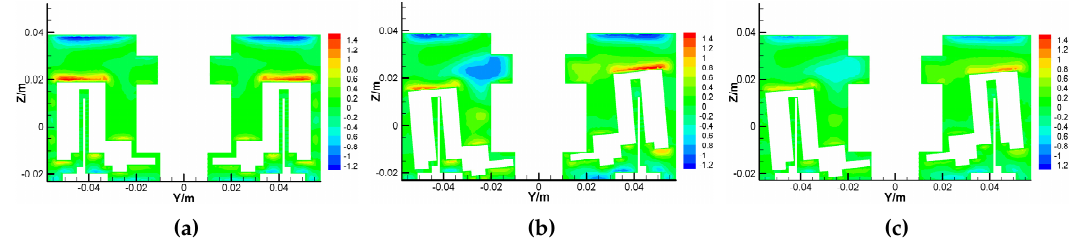
Figure 12. Radial velocity contours of the GyroWheel under φ y = 0 ◦ . ( a ) Results under φ x = 0 ◦ and 3500 rpm; ( b ) Results under φ x = 5 ◦ and 3500 rpm; ( c ) Results under φ x = 5 ◦ and 2000